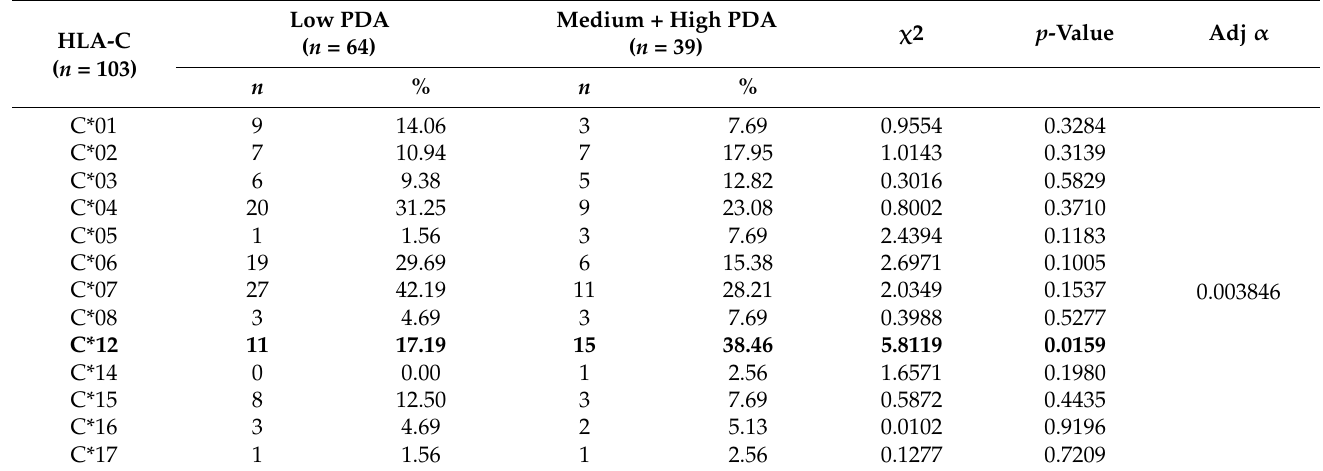
Table 3. Correlation between PDA and HLA-C.